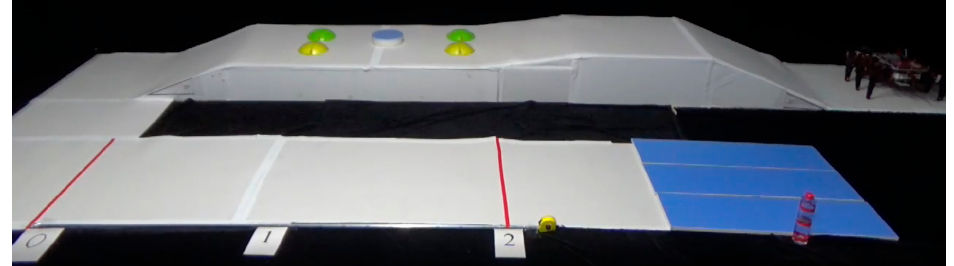
Figure 9. Walking experiment indoors. The number 0, 1, and 2 at the bottom of the figure represents the distance the robot walks in a straight line.